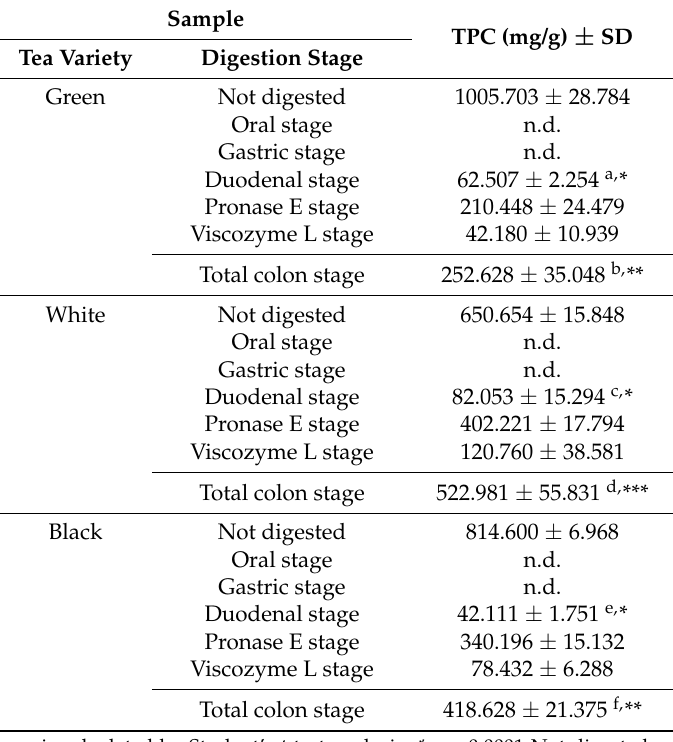
Table 1. Total Phenol Content (TPC) evaluated by Folin-Ciocalteu method. Data are expressed as